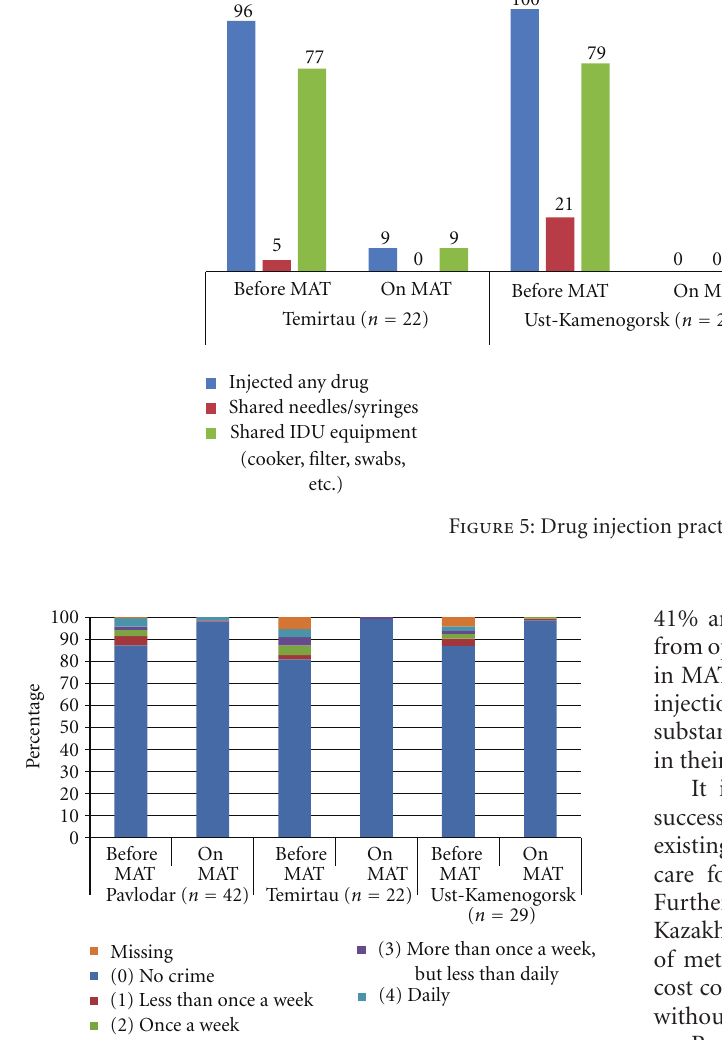
Figure 6: Criminal behavior before and after enrollment in medication-assisted